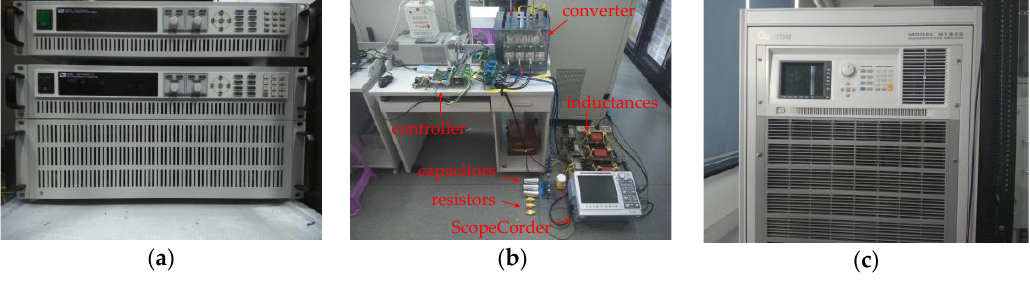
Figure 24. The experimental test bed: ( a ) DC voltage source; ( b ) main circuit, controller and ScopeCorder; ( c ) grid simulator.